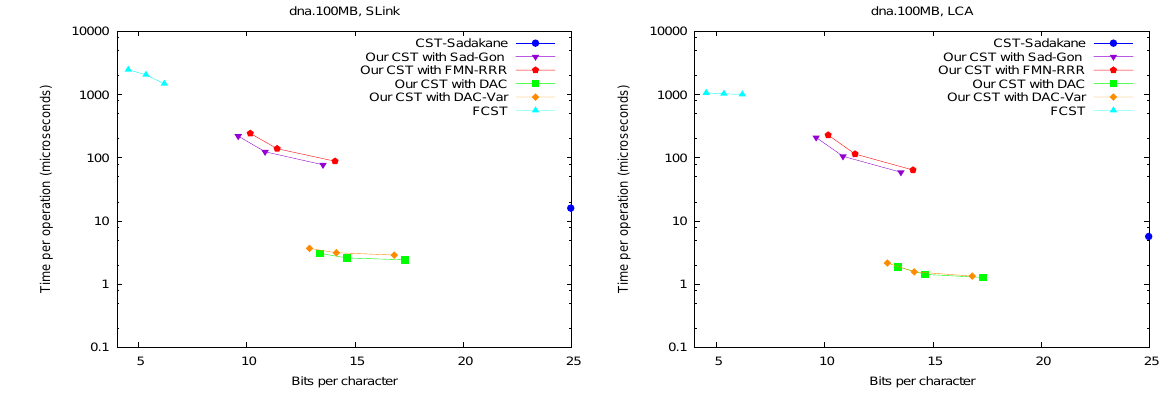
Space/Time trade-off performance for operations SLink and LCA . Note